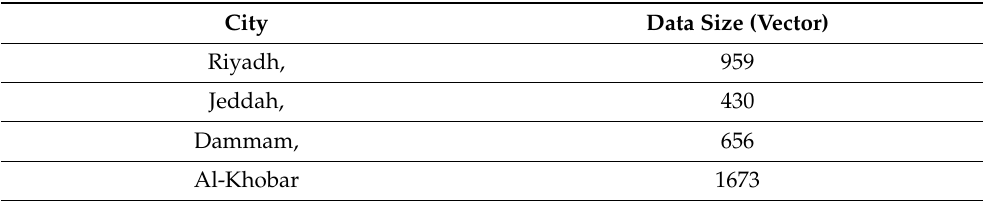
Table 1. Size of dataset. City Data Size